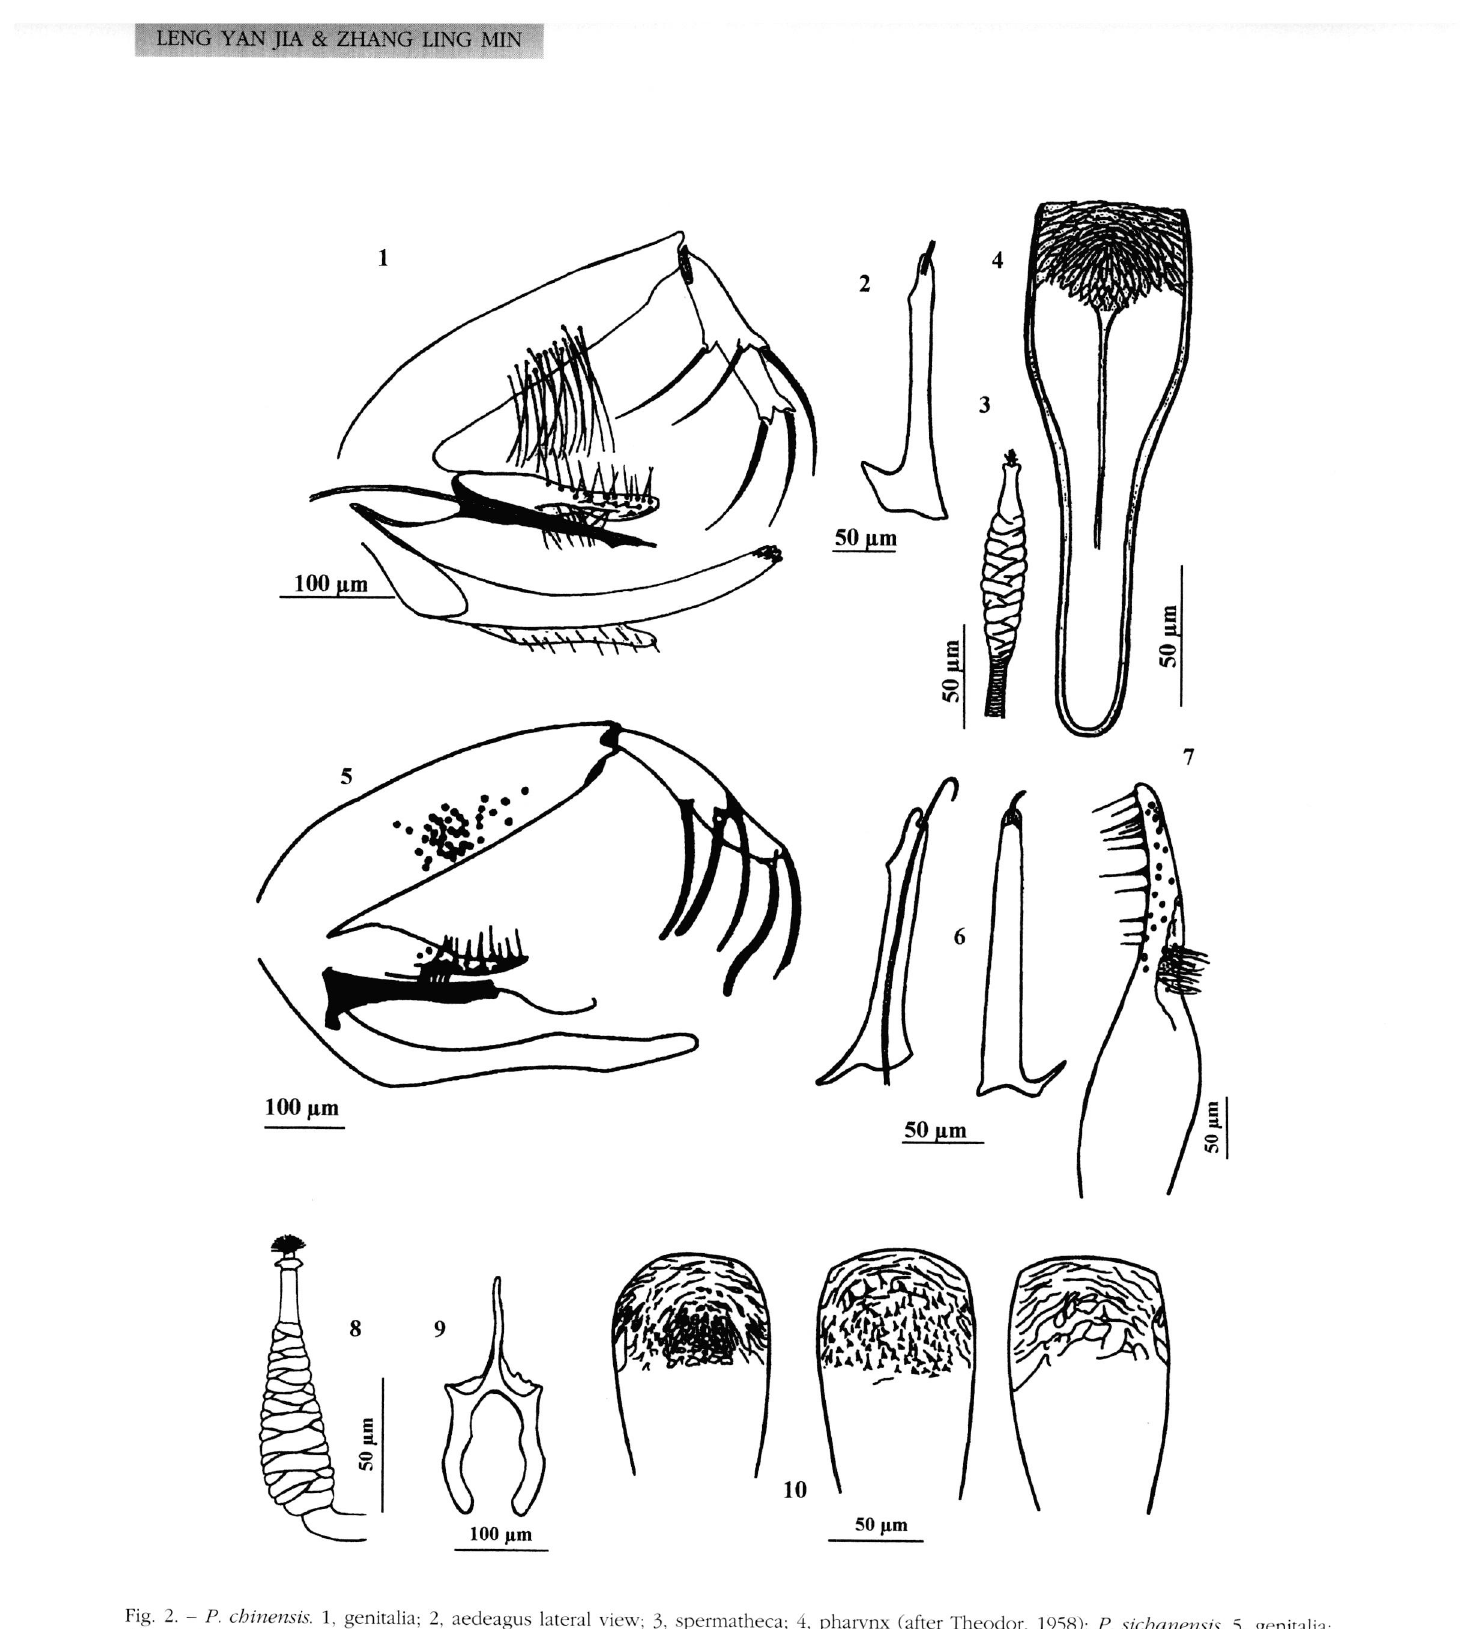
6 Parasite, 2001, 8, 3-9 Mise au